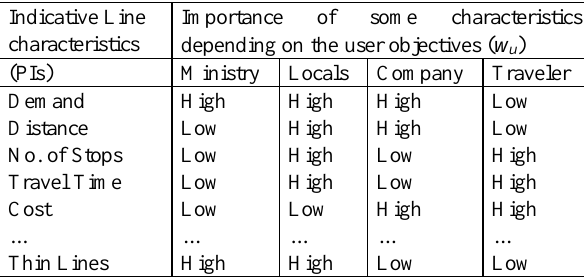
Table 3. An indicative weighting of some PIs, when calculating the overall KPI for the cost function for different